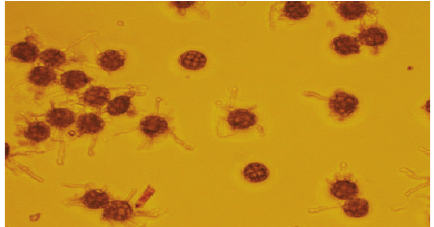
Figure 4: Examples of germinated and ungerminated pollen grains of S. senegal .